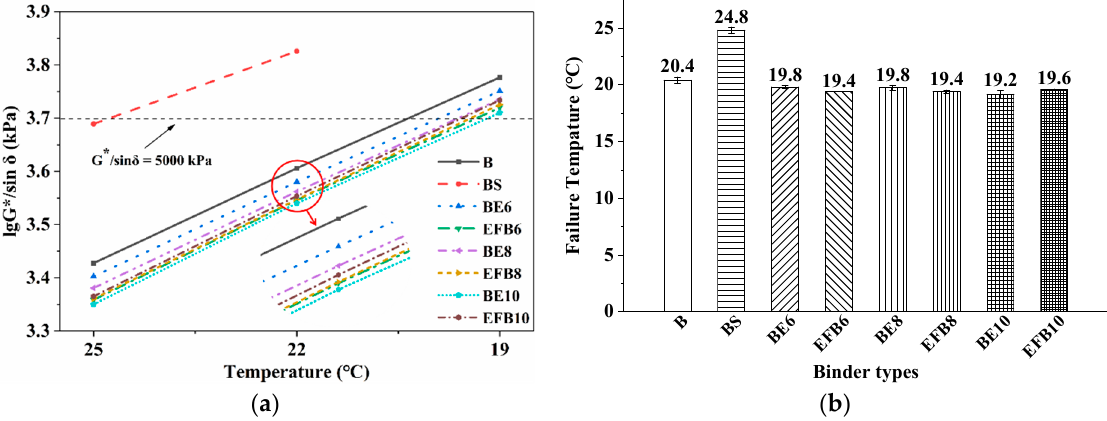
Figure 7. Fatigue performance: ( a ) fatigue factor versus temperature and ( b ) failure temperatures.